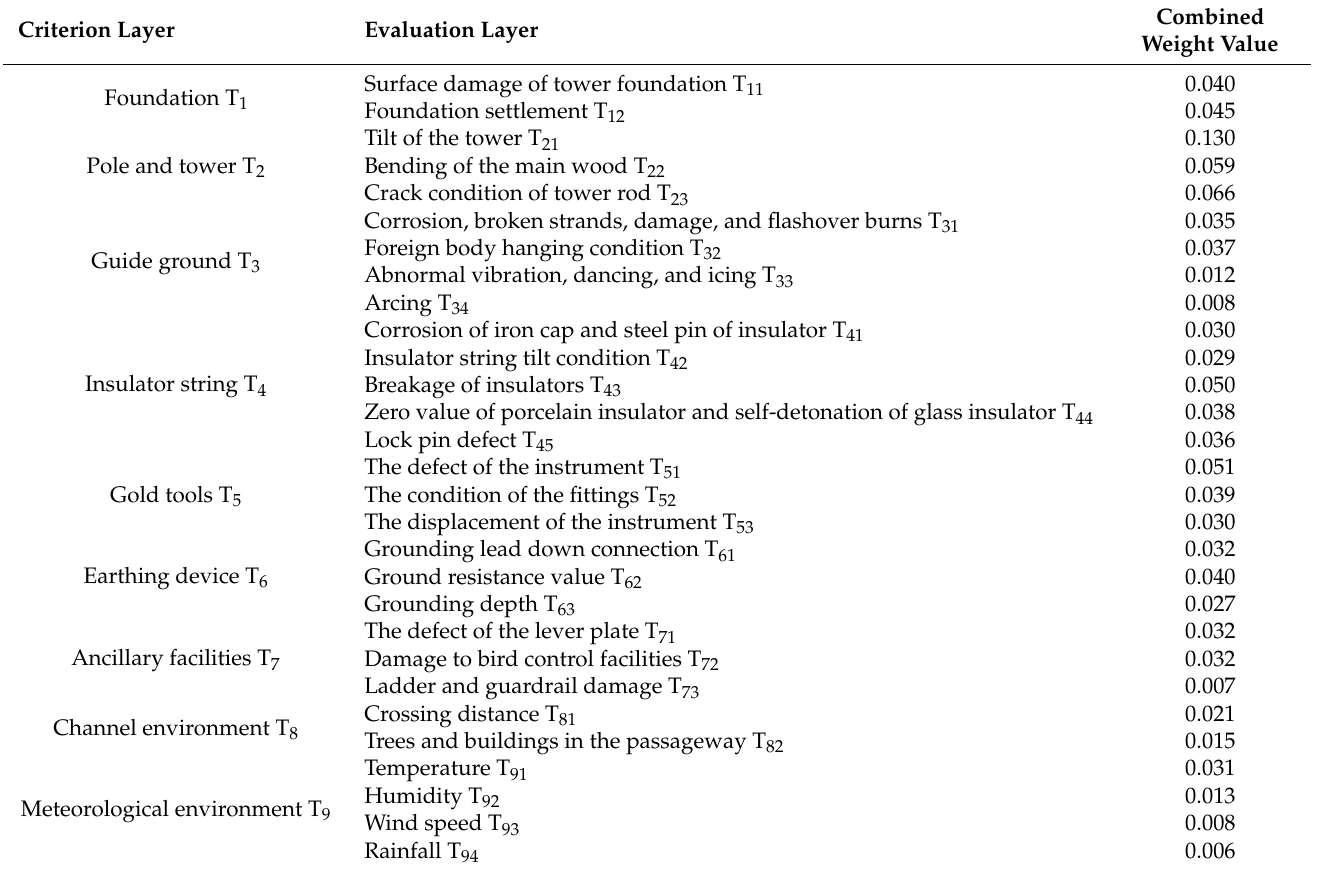
Table 12. Updated weight table of evaluation index combination based on inspection defect parameters.